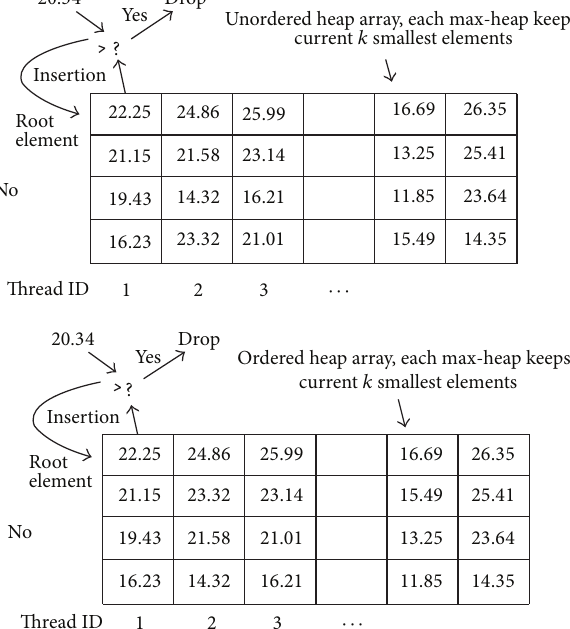
Figure 4: Two types of heap-array built for features of query images (ordered heap keeps the stored minimum elements ordered, but unordered heap does not need this